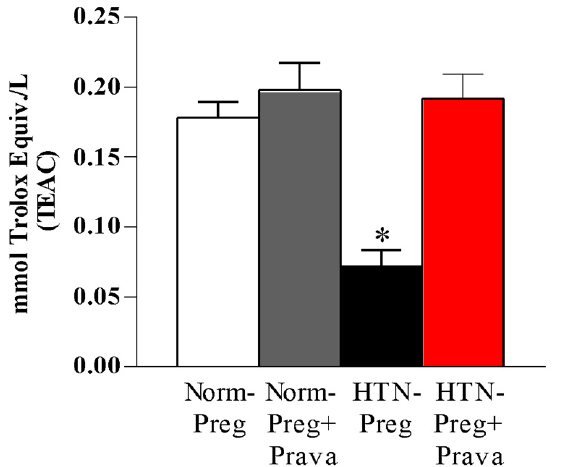
Figure 6. The Trolox equivalent antioxidant capacity (TEAC) in plasma determined in Norm-Preg, Norm-Preg + Prava, HTN-Preg, and HTN-Preg + Prava groups. Values represent mean ± SEM. * p < 0.05 vs. Norm-Preg group.